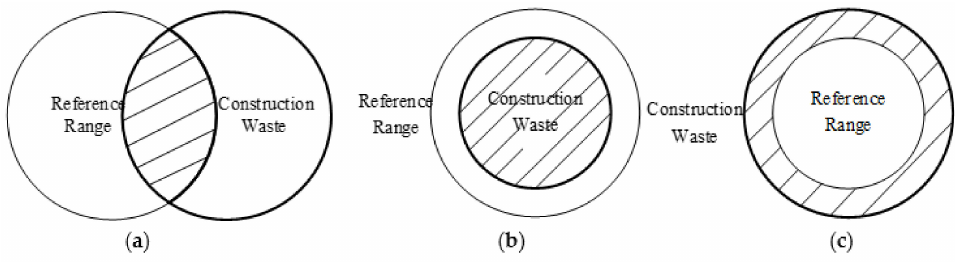
Figure 13. The criterion of separability quality analysis: ( a ) the separability meets the requirements, ( b ) the separability is considered to meet the requirements, ( c ) separability is considered to meet the